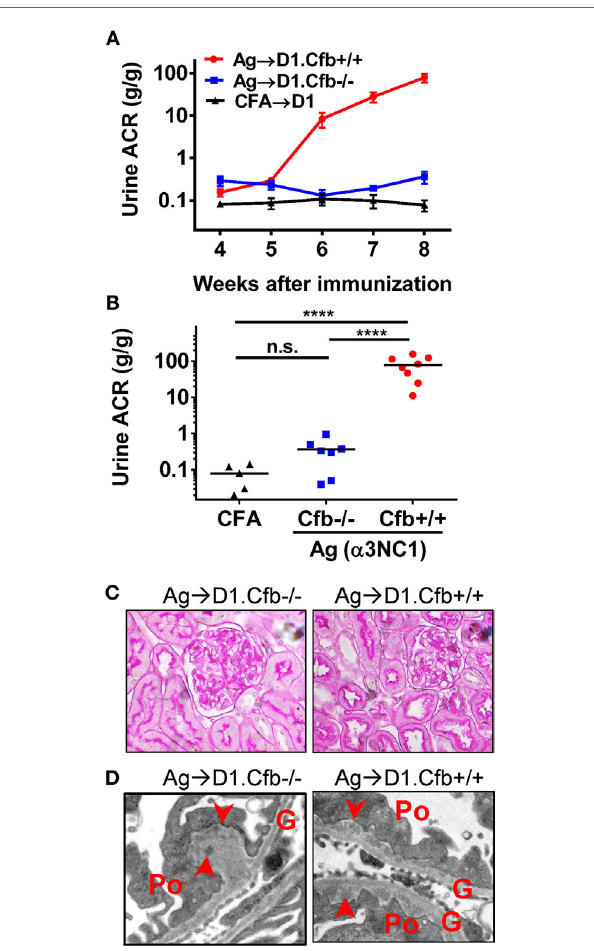
FigUre 7 | D1.Cfb − / − mice immunized with α 3NC1 are protected against albuminuria despite developing subepithelial immune complexes. (a) Time course of urinary albumin-to-creatinine ratio (ACR) in D1.Cfb + / + mice (circles) and D1.Cfb − / − mice (squares) immunized with α 3NC1 ( N = 7–8 per group). Control D1 mice (triangles), including both genotypes, were immunized with adjuvant alone ( N = 5). Shown are means and SEM. (B) Scatterplot depicts the ACR values at the last time point (week 8). The significance of differences among groups was analyzed by one-way ANOVA with Dunnett’s correction multiple comparisons. *** P < 0.001, **** P < 0.0001, n.s., not significant. (c) Morphology of kidneys from α 3NC1-immunized D1.Cfb − / − (left) and D1. Cfb + / + mice (right) appeared normal by light microscopy (periodic acid–Schiff staining, original magnification 400 × ). (D) Transmission electron microscopy shows subepithelial electron dense deposits (arrowhead), thickening of the glomerular basement membrane (G), and podocyte (Po) foot process effacement. Original magnification 15,000 × .